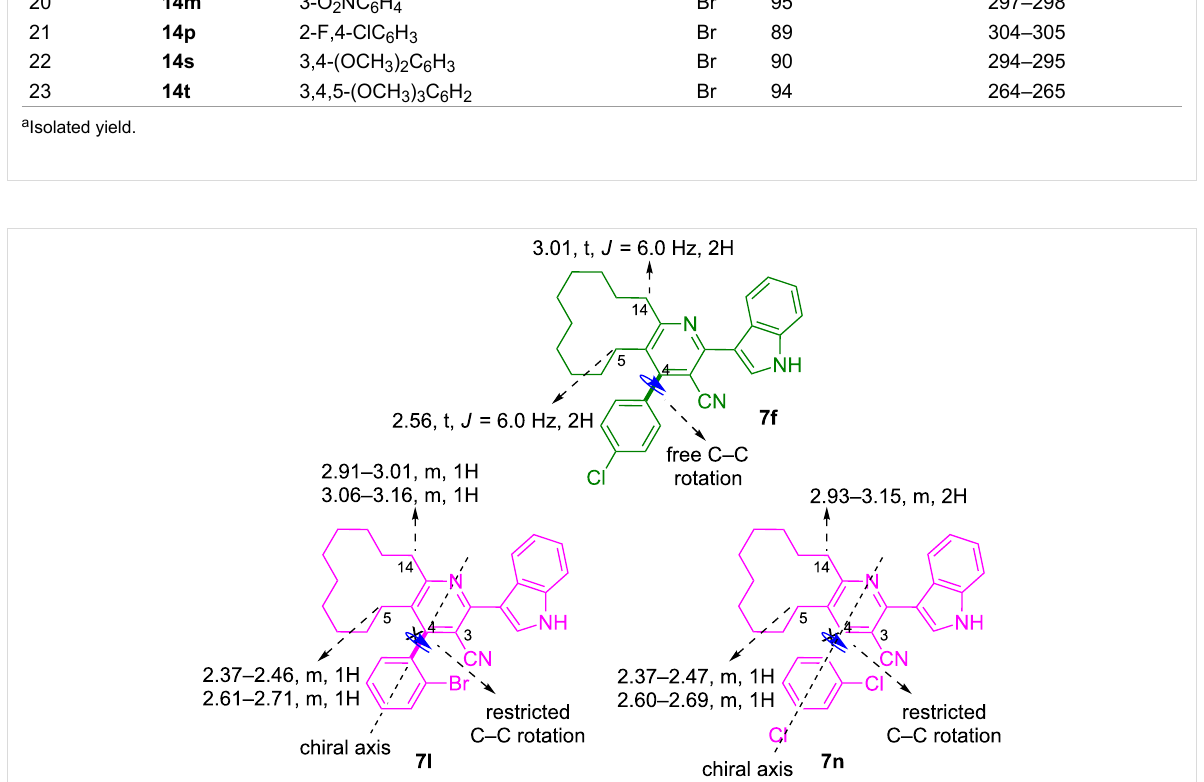
Figure 2: Axial chirality due to restricted C–C bond rotation (representative cases).